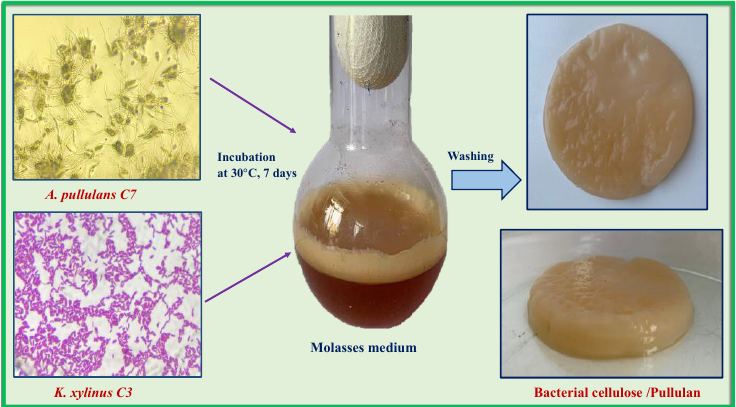
Figure 3. Preparation of bacterial cellulose/pullulan (BC/PUL) biocomposite by cocultivation. According to the data obtained, the yield of BC/PUL composite on the medium with molasses is 1.6 times higher than on the medium with glucose (Table 2). Table 2. The yield of BC and PUL after 7 days of static cultivation. Glucose Medium Molasses Medium